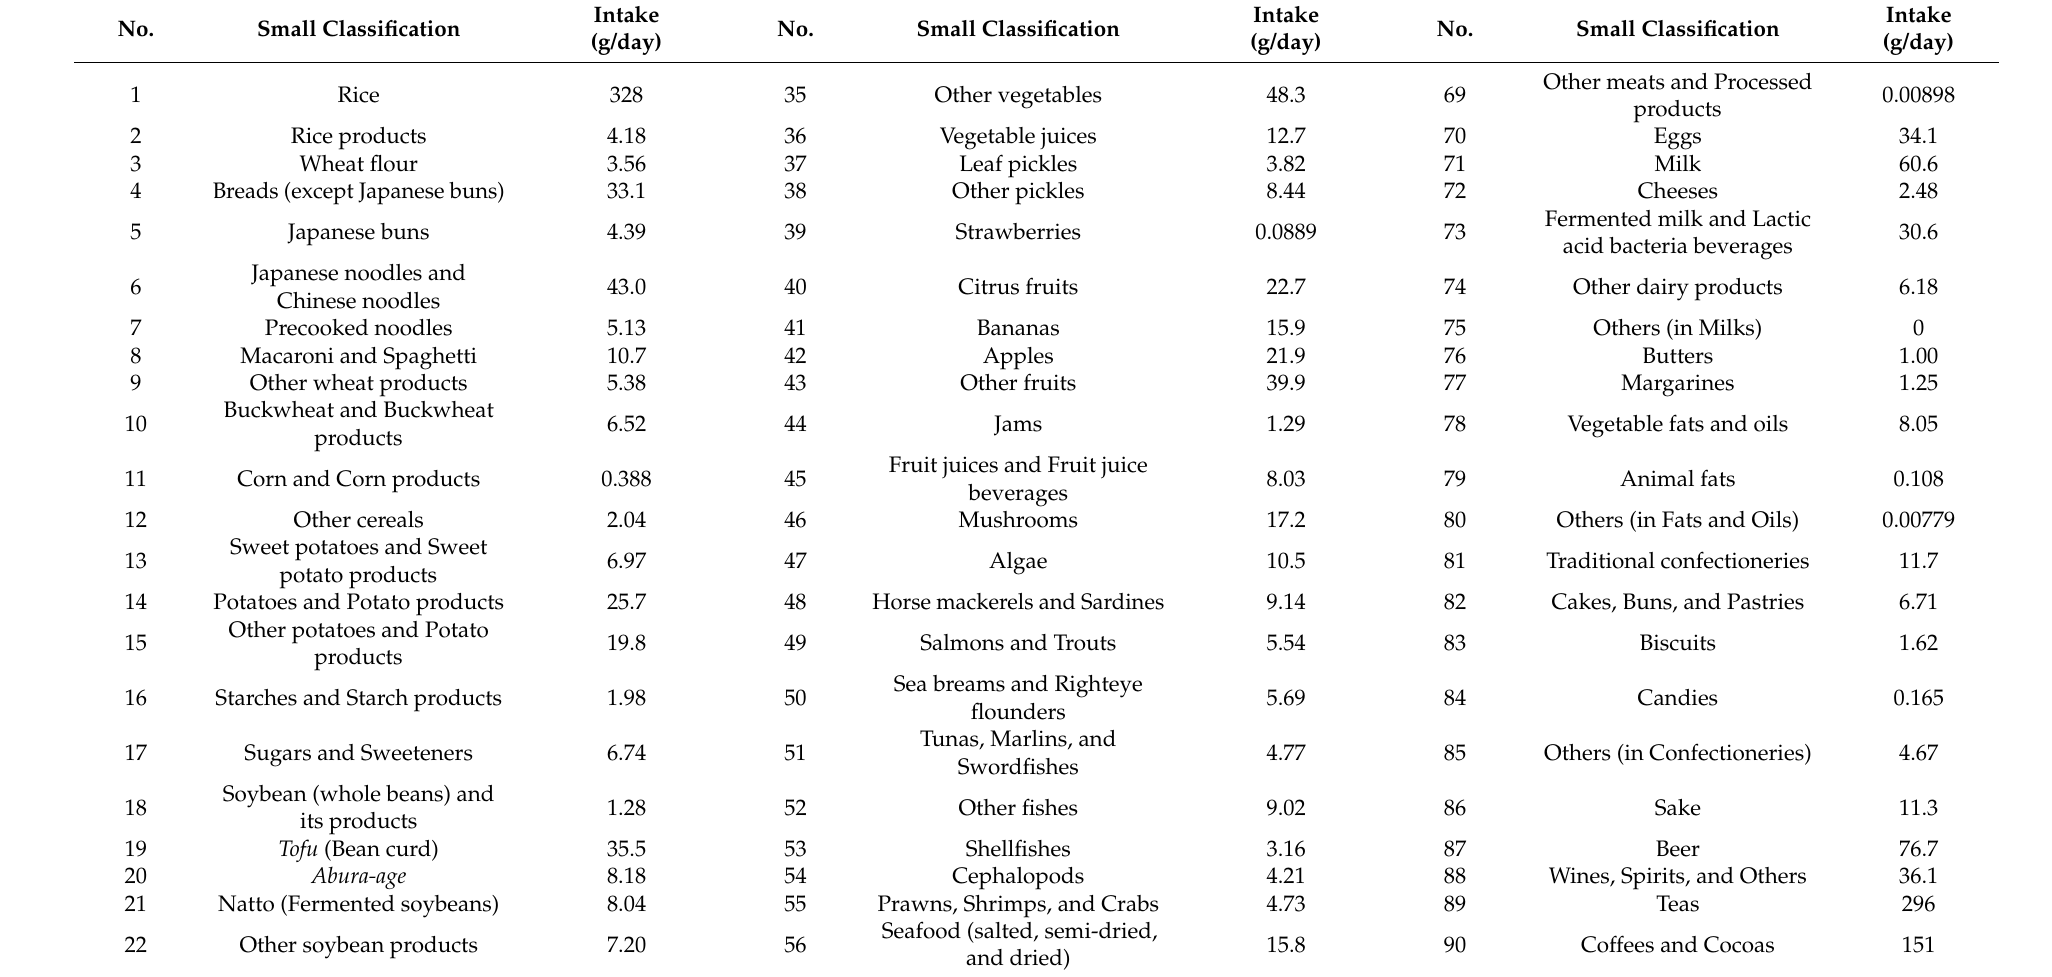
Table 2. Food category and intake used in this study. Here 1–98 corresponds to small classifications shown in